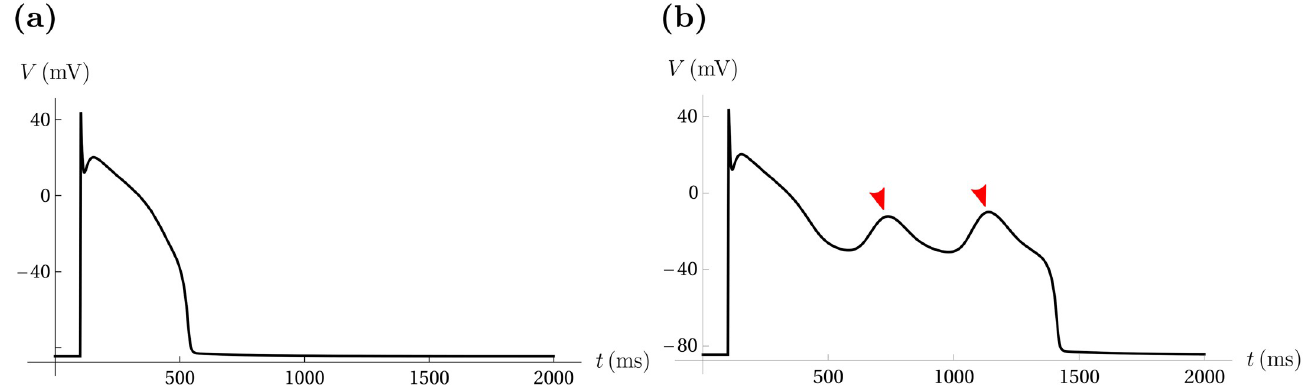
Fig 1. EADs in cardiac AP simulations. Cardiac APs can exhibit EADs in response to changes in the gating properties of L-type Ca 2+ channels. ( a ) A simulated cardiac AP without EADs. ( b ) An AP exhibiting two EADs (red arrow markers) has a significantly prolonged duration.